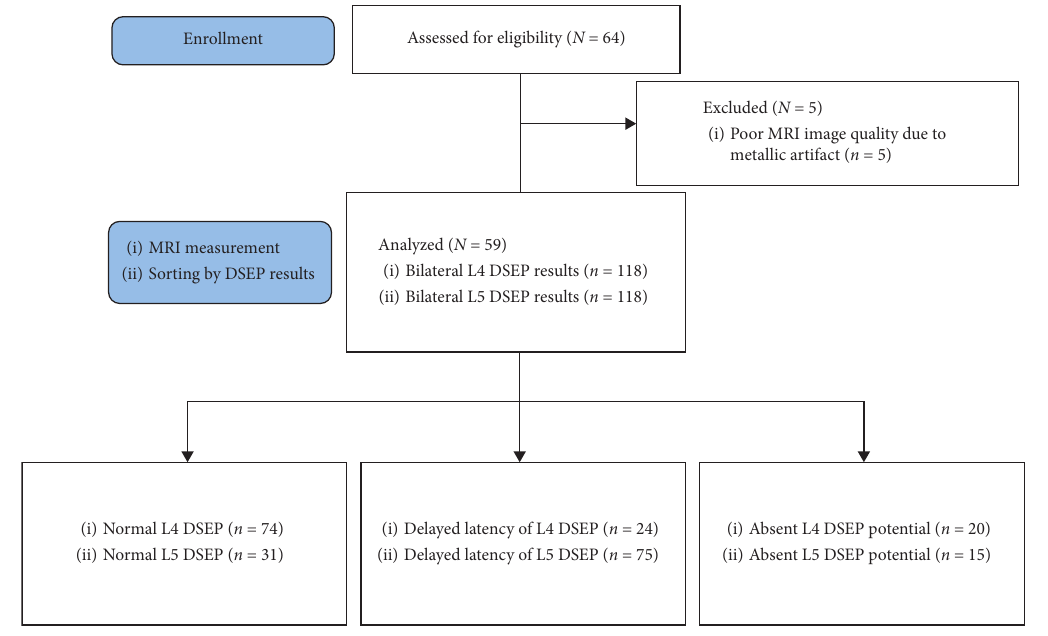
Figure 1: Participant flow diagram. DSEP: dermatomal somatosensory evoked potentials. Table 1: General subject